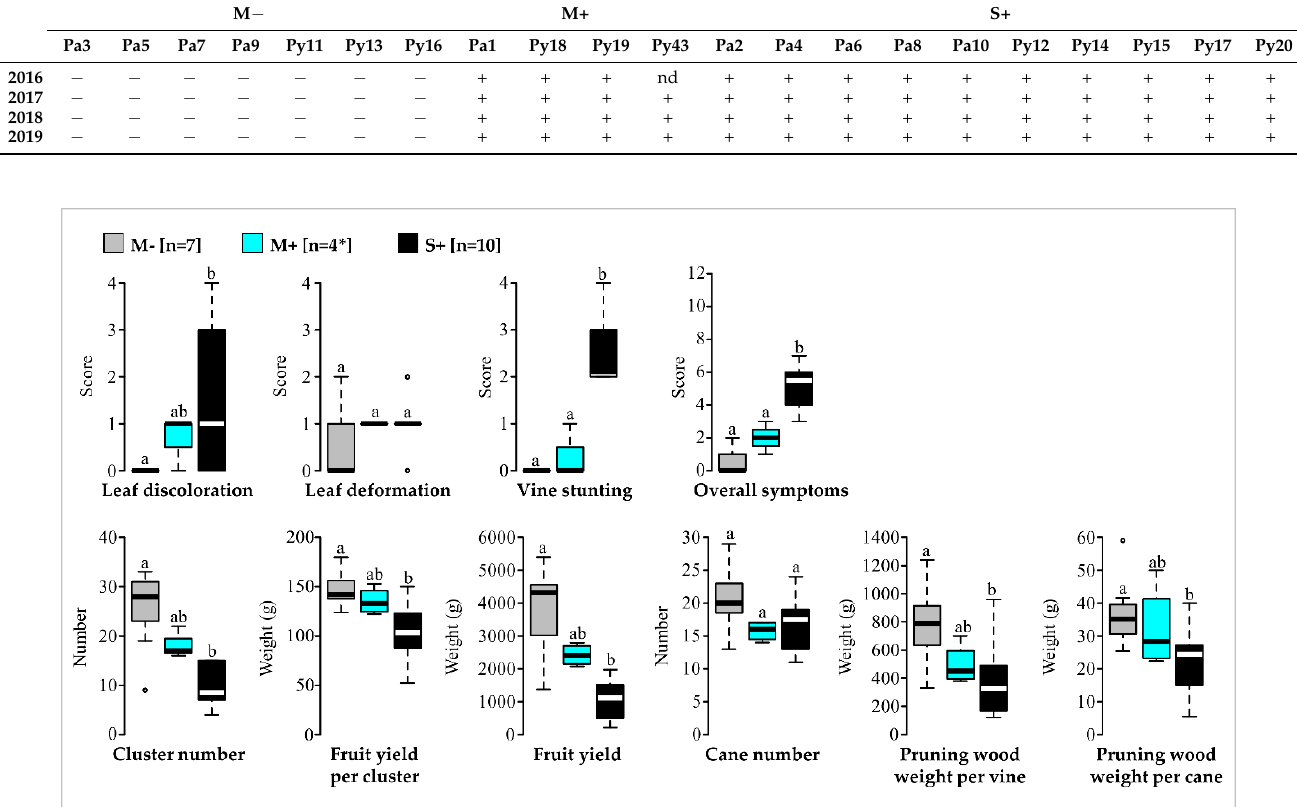
Figure 1. Comparative analyses of qualitative and quantitative traits for the three vine categories in 2016 (M − , mild symptomatic GFLV-free vines (in grey); M+, mild symptomatic vines infected with GFLV (in cyan) and S+, severe symptomatic vines infected with GFLV (in black)). Number of vines (n) are given in brackets. * For the vines in the M+ category, only three vines were considered in June 2016 for the evaluation of qualitative traits (leaf discolouration, leaf deformation, vine stunting, overall symptoms). Significance was tested with Student’s t , Welch’s t or Kruskal–Wallis H tests. Boxplots show the median (horizontal bold line) and the interquartile range with lonely dots representing extreme data. Different letters (a,b) indicate significant differences ( p ≤ 0.05). Raw data and results of the statistical tests are available in Tables S1 and S3.